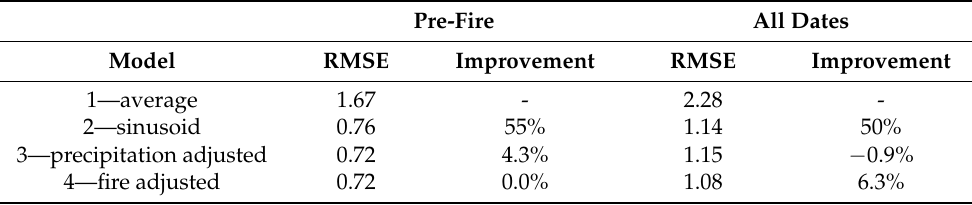
Figure 8. Sinusoidal model #2 (in blue) fits much better than constant model #1, reducing the root mean squared error (RMSE) by 50% for the study period from 1993–2000 and by 55% for the pre-fire years of 1993–1996 (Table 4). Table 4. Root mean squared error (RMSE) for each of the four models.